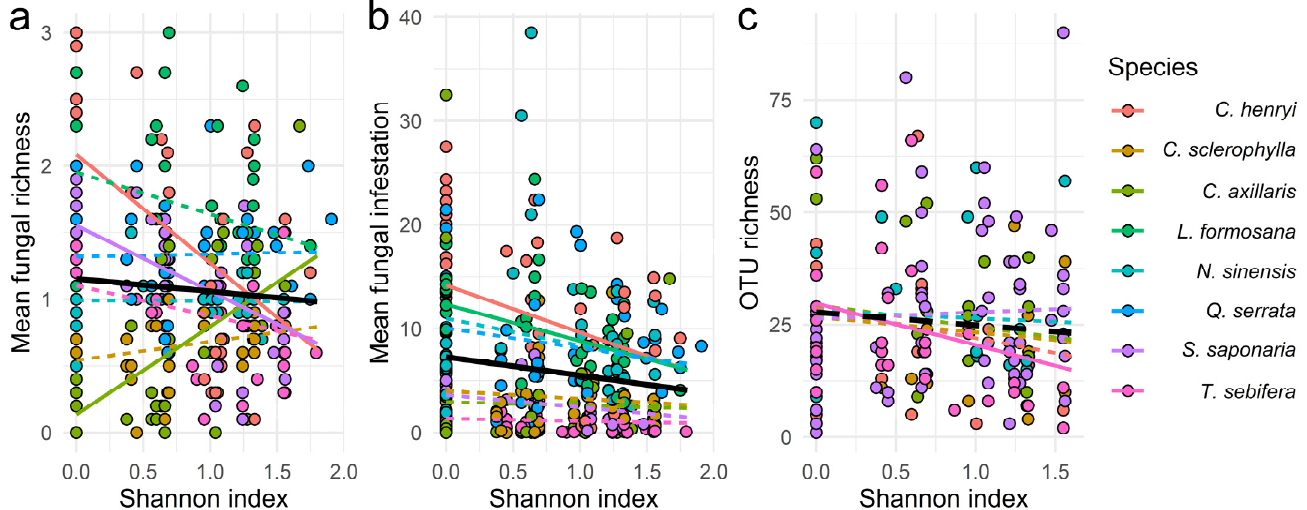
Figure 2. Effects of Shannon diversity in the local neighbourhood on ( a ) mean fungal richness and ( b ) mean fungal infestation, both based on visual assessment data and ( c ) on OTU richness. The overall regression line (in black) was obtained from a mixed model with Shannon diversity as the fixed factor and species identity and neighbourhood composition as random factors ( a ) p = 0.0330, ( b ) p = 0.0041, ( c ) p = 0.0645. The species-specific regression lines (in colour) were obtained from a mixed model with Shannon diversity and species identity as the fixed factors and neighbourhood composition as random factor. Regression solid and dashed lines represent significant ( p < 0.05) and non-significant ( p > 0.05) effects, respectively, according to a non-overlap of the confidence intervals of the unbiased predictors for the slopes with zero.